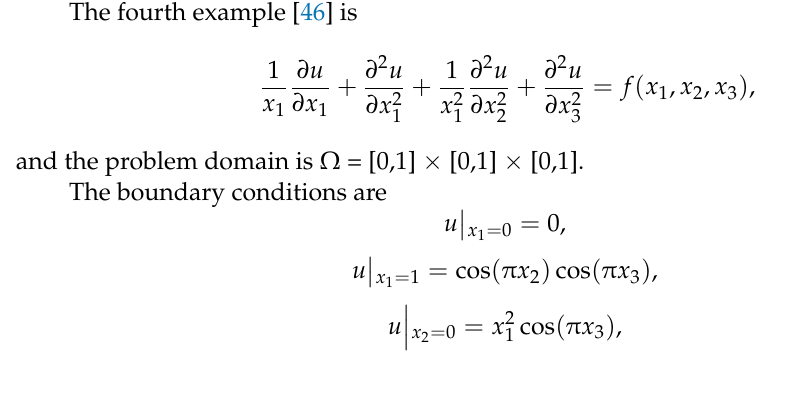
Figure 15. The comparison of numerical and exact solutions along x 3 -axis.